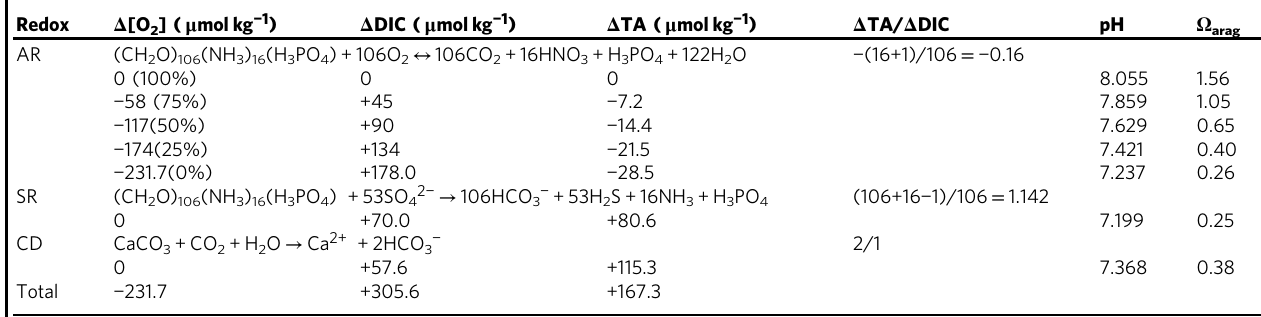
Table 2 O 2 consumption and DIC and TA production during sequential aerobic respiration, sulfate reduction and carbonate mineral dissolution in bottom waters 45, 83